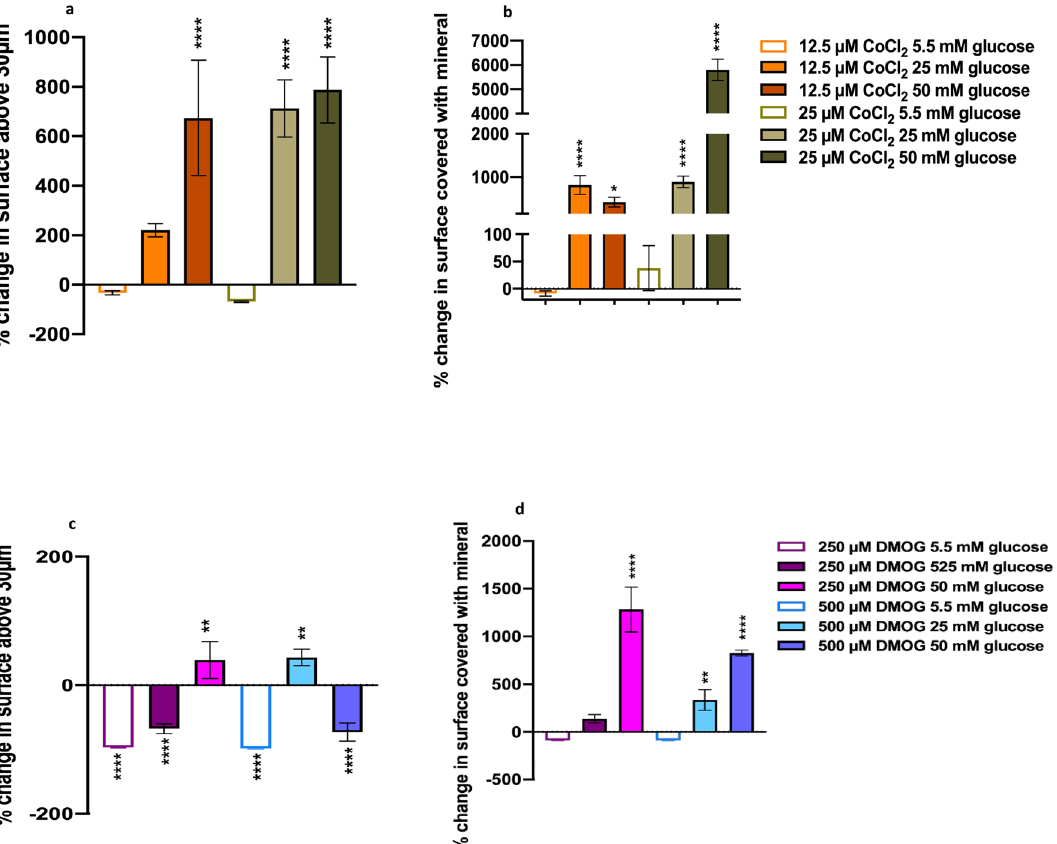
Figure 5. Quantification of bone nodules restored by CoCl 2 and DMOG treatment in hyperglycaemic conditions using interferometry and ImageJ. ( a ) The percentage change (percentage change compared corresponding glucose levels in atmospheric O 2 ) in the surface covered with nodules (above 30 µm compared to untreated control (similar level of glucose) without CoCl 2 as quantified with interferometry and ( b ) 2D image analysis of area of surface covered by mineral. Both 12.5 µM CoCl 2 and 25 µM CoCl 2 recovered nodule formation in moderate (25 mM) and high (50 mM) environments. ( c ) DMOG interferometry and ( d ) Image J analysis also revealed that both 250 µM DMOG and 500 µM DMOG restored nodule formation, however, DMOG exhibited a reduced restoration capacity compared to CoCl 2 . Error bars represent the SD from the mean values. *P ≤ 0.05; **P ≤ 0.01; ****P ≤ 0.0001 (n =